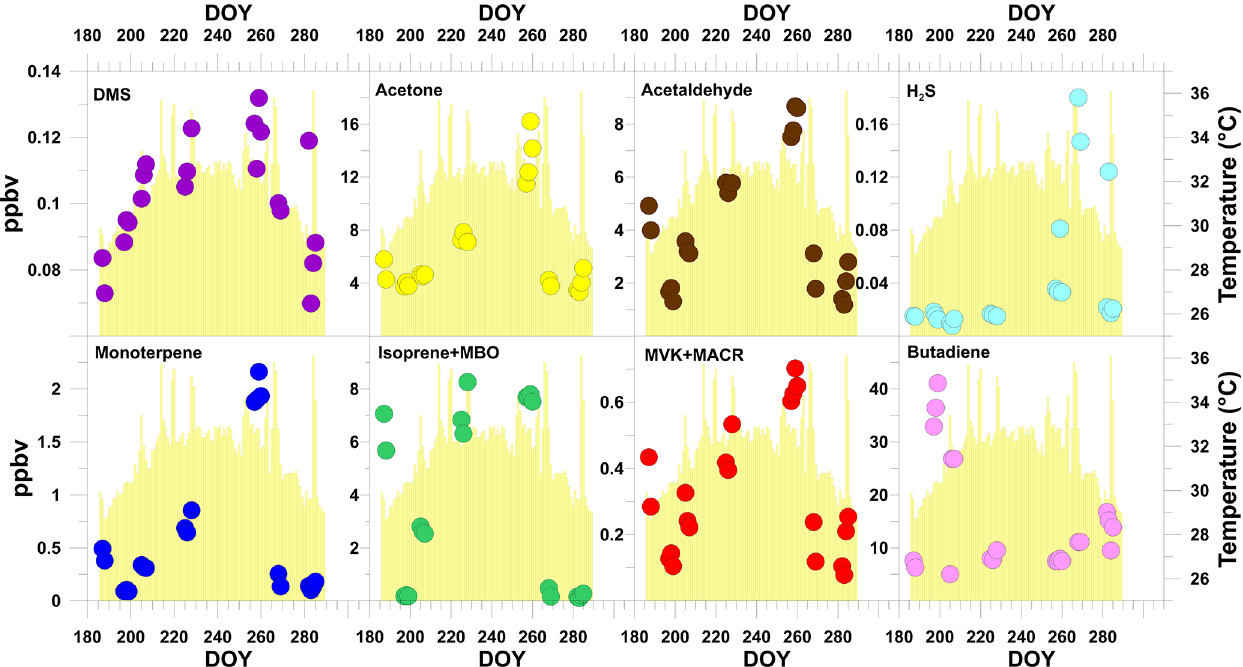
Figure 2. The daytime average of selected VOCs. Yellow bars indicate the average daily temperature. DOY indicates the day of the year. For average diurnal profiles, see Figs.